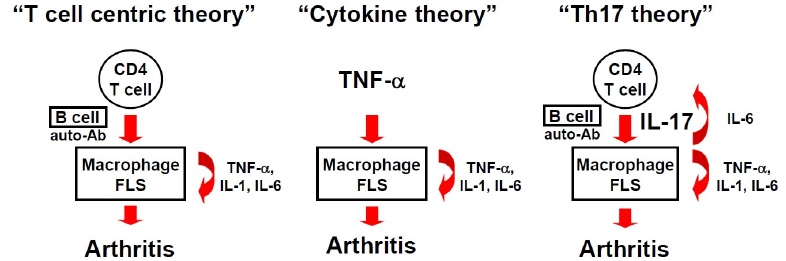
Figure 1. Historical transition of the theories for rheumatoid arthritis (RA) development. AutoAbs, autoantibodies; fibroblast-like synoviocytes (FLSs), fibroblast-like synoviocytes.